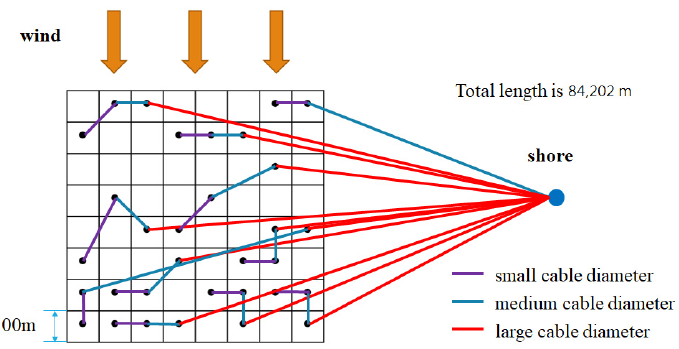
Figure 12. Optimal cable layout by restricting a maximum of three interconnecting turbines.